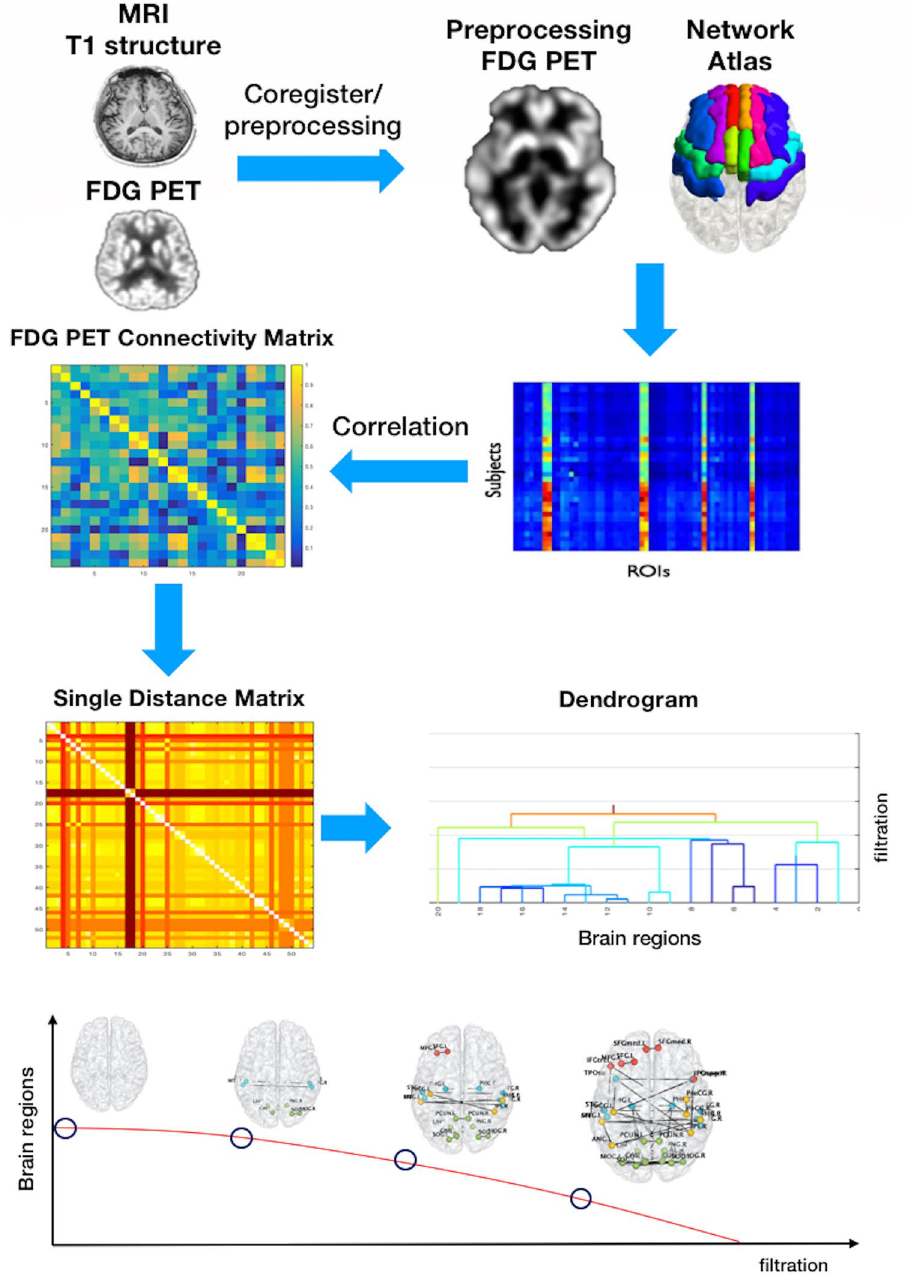
homology graph of filtration enabled us to track the construction of all regions connected to the network as the filtration value